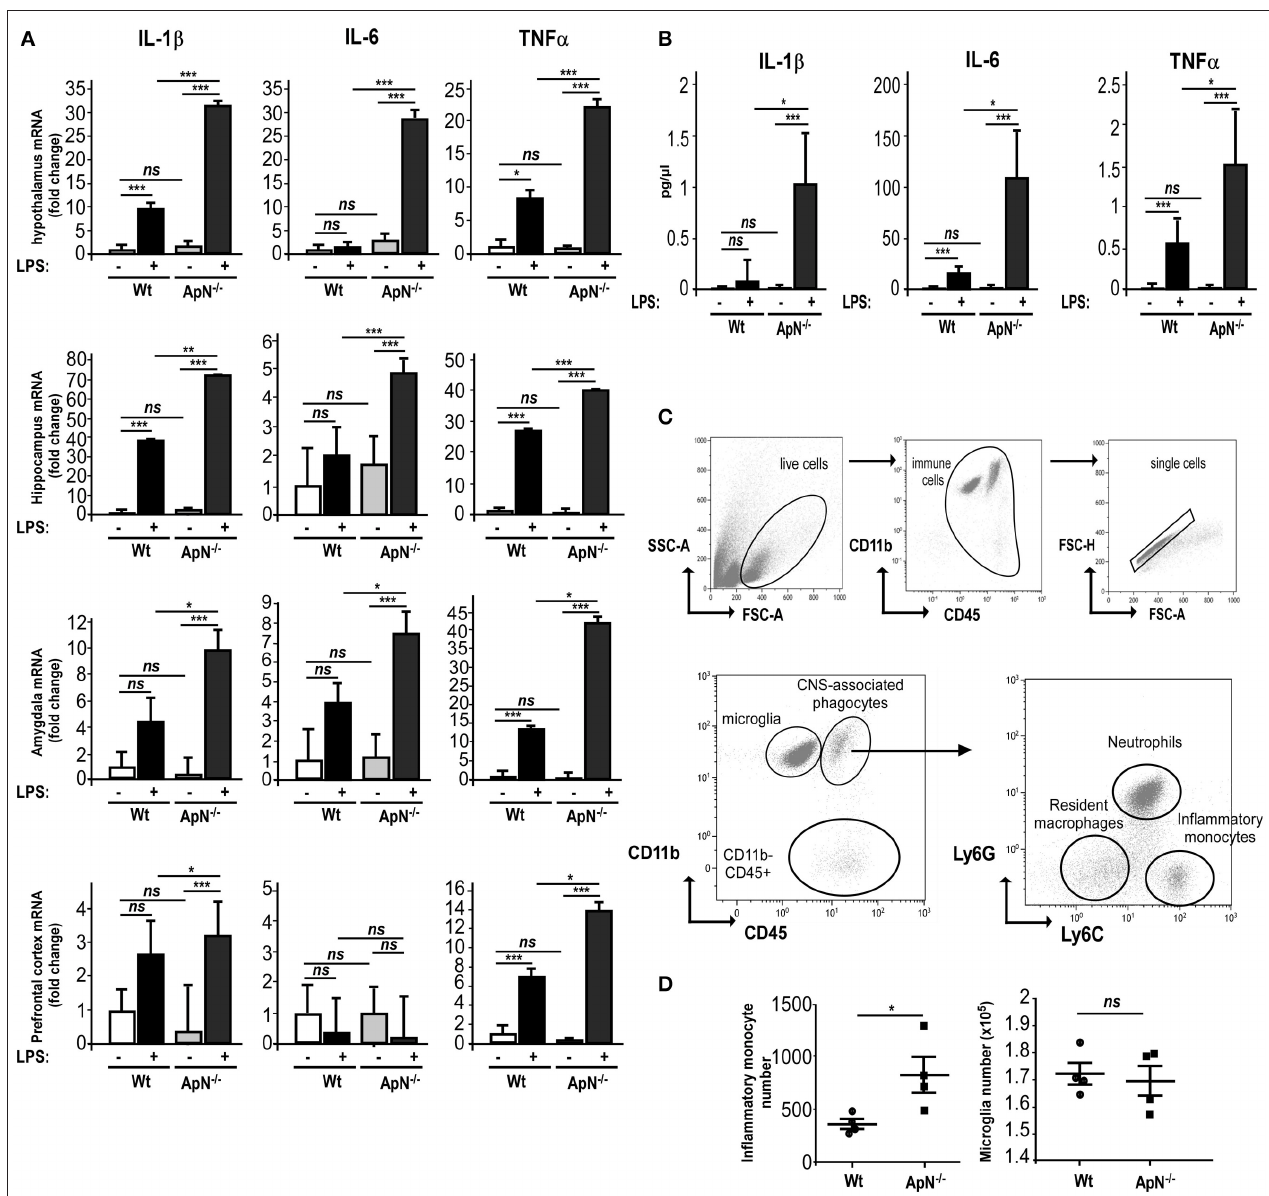
FIGURE 1 | Adiponectin deficiency exacerbates neuroinflammatory responses to LPS ip administration. (A) Twenty-four hours post saline or LPS ip administration, brains from Wt (white and gray bars, respectively) or ApN − / − mice (black and dark gray bars, respectively) were dissected and pro-inflammatory genes IL-1 β , IL-6, and TNF α mRNA levels were determined by quantitative PCR from hypothalamus, hippocampus, amygdala, and prefrontal cortex. Bars represent the mean expression levels s (where s s2 2 ), s1 standard deviation of the 1 Ct of the gene of interest among replicates and s2 √ (s1 2 ± = + = the housekeeping genes among replicates) expressed as fold change compared to saline injected Wt mouse brains. Kruskal–Wallis test followed by the Iman-Conover method for multiple comparison between groups was performed on 1 Ct values, * p < 0.05, ** p < 0.01, *** p < 0.005 vs. saline control; ns, non-significant, n (B) Concentrations of IL-1 β , IL-6, and TNF α cytokines in CSF of saline and LPS-treated Wt mice (white and black bars, respectively) or saline and LPS-treated ApN − / − mice (light gray and dark gray bars, respectively) were measured as indicated in the Materials and Methods section. N Mann & Whitney for comparison between groups, * p < 0.05, *** p < 0.005. (C) Representative bivariate dot plots of Percoll isolated brain cells illustrating gating strategy on CD11b + /CD45 low + for microglia, CD11b + /CD45 high + for CNS-associated phagocytes and CD11b − /CD45 high + cells. Among CNS-associated phagocytes, three subpopulations can be discriminated, i.e., CD11b + /CD45 high + /Ly6G − /Ly6C − resident monocytes, CD11b + /CD45 high + /Ly6G + /Ly6C med neutrophils and CD11b + /CD45 high + /Ly6G − /Ly6C + inflammatory monocytes. (D) Immune brain cells were isolated and analyzed as described in the Materials and Methods section. Dot plots show the number of inflammatory monocytes (left panel) and microglia (right panel) in Wt and ApN − / − mouse brains after LPS challenge. Bars represent mean SEM, n 4 per ± =